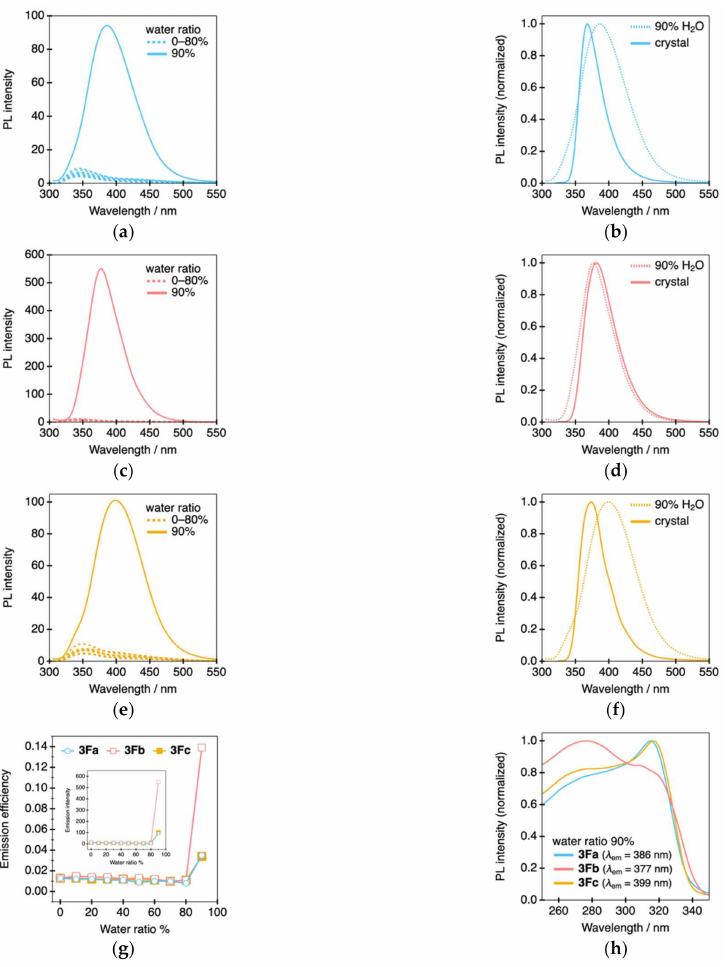
Figure 7. PL spectra of ( a ) 3Fa , ( c ) 3Fb , and ( e ) 3Fc in THF/water mixed solvent ( λ ex = 290 nm). Differences in the PL spectra between the molecular aggregates obtained in the THF/water system and crystalline states for ( b ) 3Fa , ( d ) 3Fb , and ( f ) 3Fc . ( g ) Relationship between PL efficiency and additional water ratio (inset: relationship between PL intensity and additional water ratio). ( h ) Excitation spectra of the molecular aggregates for 3Fa – c obtained after the addition of 90%